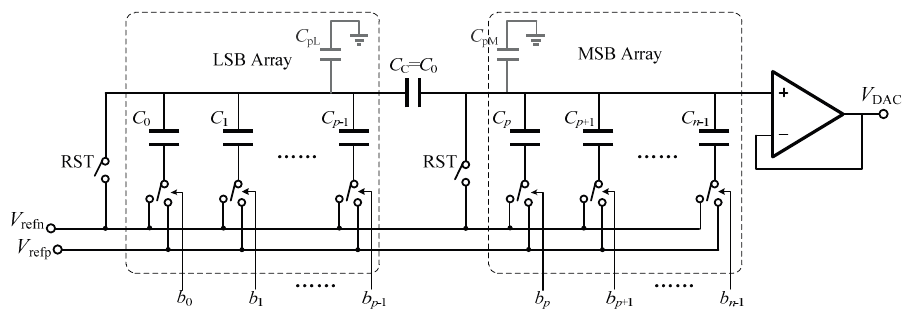
Figure 8. DAC based on the unary-weighted split-capacitor